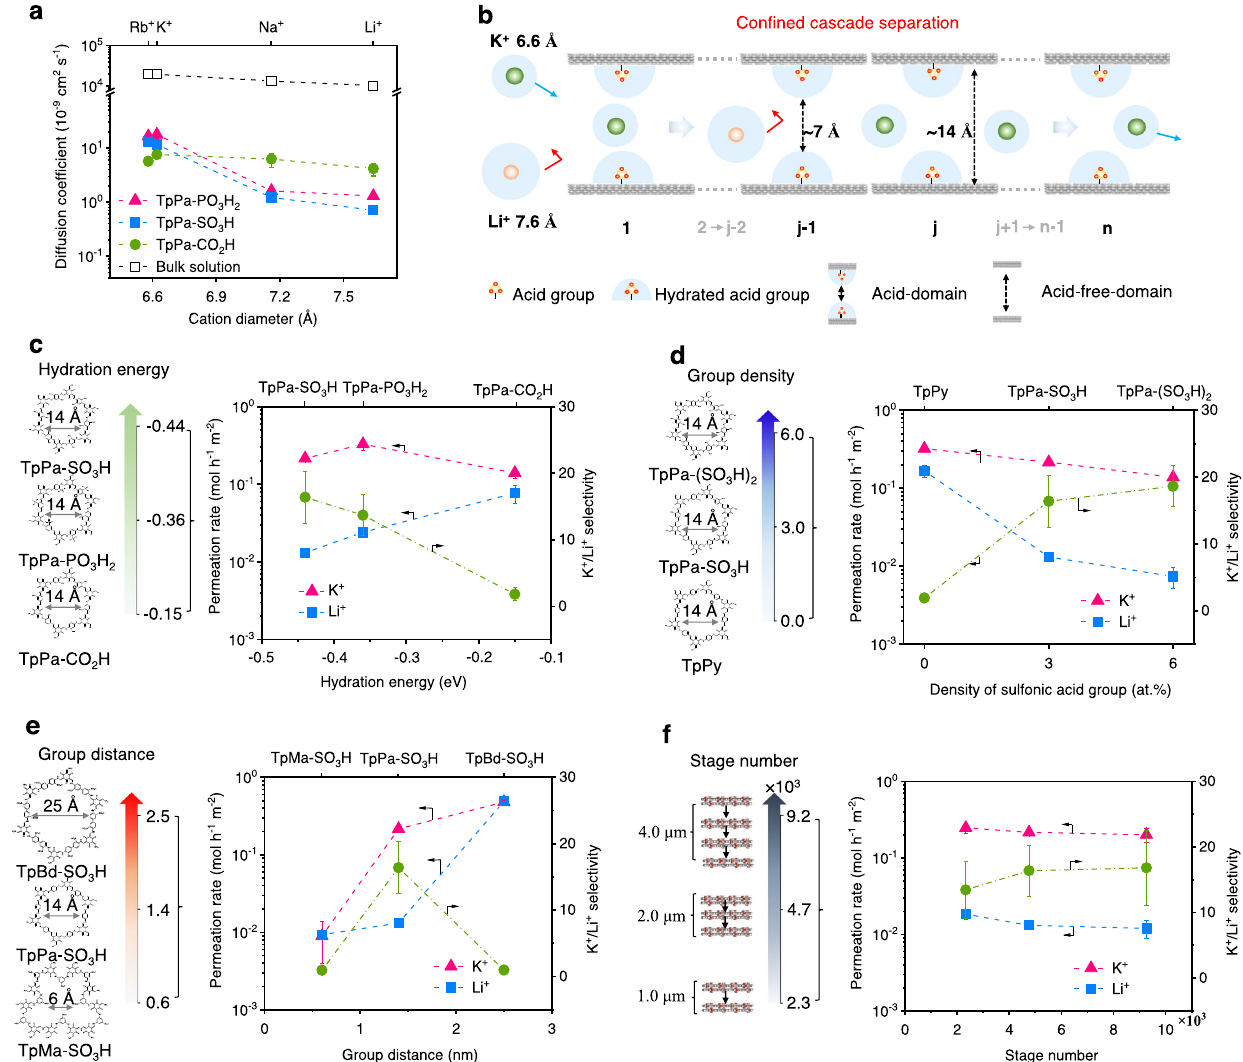
Fig. 5 | Selective transport of monovalent cations through COF membranes. a Diffusion coef fi cient of the monovalent cation with a different diameter across TpPa – PO 3 H 2 , TpPa – SO 3 H, and TpPa – CO 2 H membranes. Chloride with a con- centration of 0.1M was used as a counterion in all cases. The diffusion coef fi